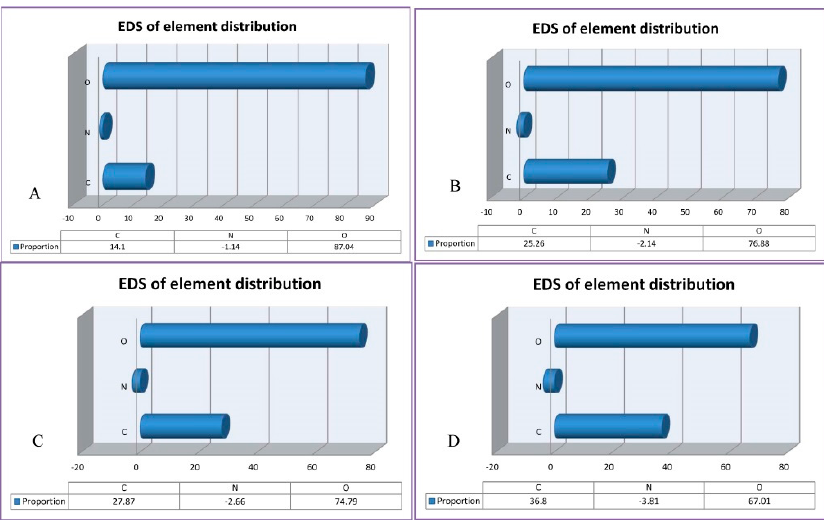
Figure 5. Energy-dispersive X-ray spectroscopy (EDS) results of regenerated MCC films from di ff erent regeneration baths: ( A ) methanol; ( B ) ethanol; ( C ) 5 wt % NaOH (aq.); ( D ) 5 wt % H 2 SO 4